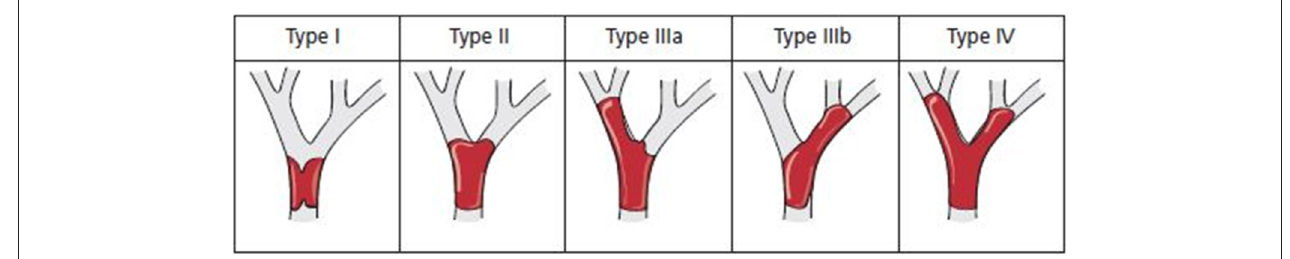
FIGURE 1 | Schematic diagram of the Bismuth–Corlette classification of hilar cholangiocarcinoma